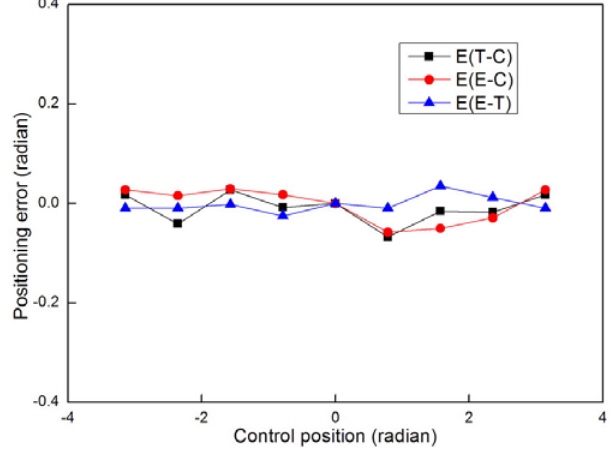
Figure 11. Error analysis of the in-situ turning test. E(T-C) denotes the error between true position and control position. E(E-C) denotes the error between calculated position and control position. E(E-T) denotes the error between calculated position and true position.